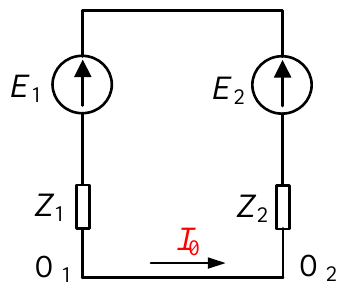
Figure 4. Simplified equivalent circuit of the generator stator windings.